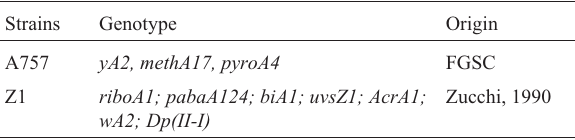
Table 1 - Genotype and origin of strains.